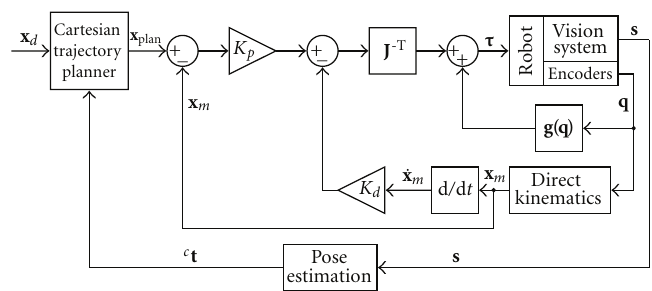
Figure 4: Dynamic look and move PBVS control.